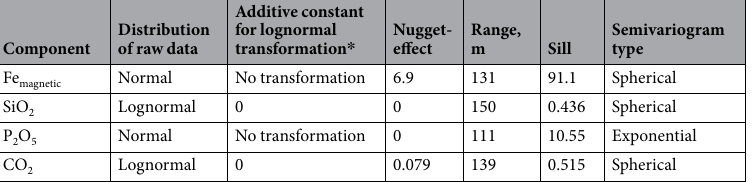
Table 4. Parameters of bulk-rock chemistry interpolation by ordinary kriging of the Kovdor phoscorite- carbonatite complex. * In case of lognormal distribution of raw data, i.e. SiO 2 and CO 2